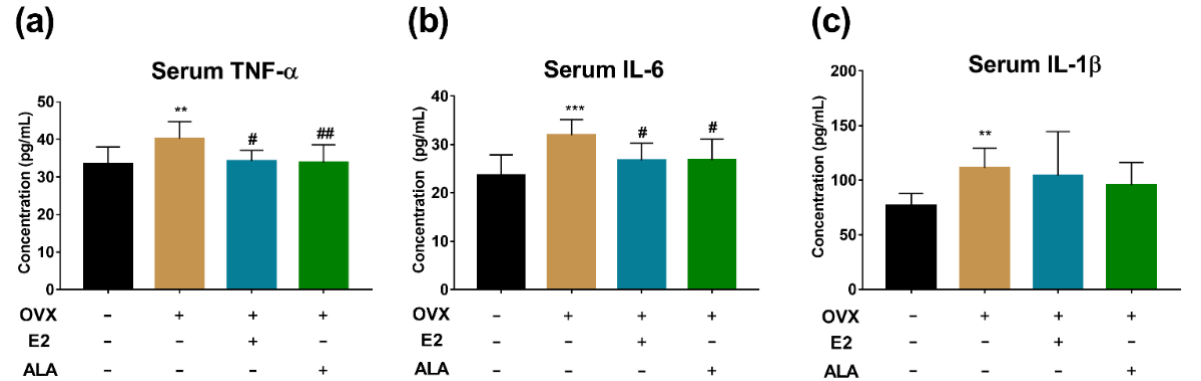
Figure 6. Effects of ALA preventive intervention on the expression levels of serum inflammatory factors. The expression levels of ( a ) TNF- α, ( b ) IL-6 and ( c ) IL- 1β in serum of ovariectomized rat models with or without ALA preventive intervention were measured by ELISA. ** p < 0.01, *** p < 0.001 vs. the SHAM group (OVX (−), E2 (−), ALA (−)). # p < 0.05, ## p < 0.01 vs. the OVX group (OVX (+), E2 (−), ALA (−)).